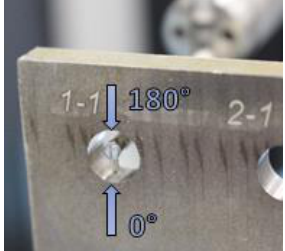
Figure 5. Measurement procedure of surface quality at 0° and 180° degrees.